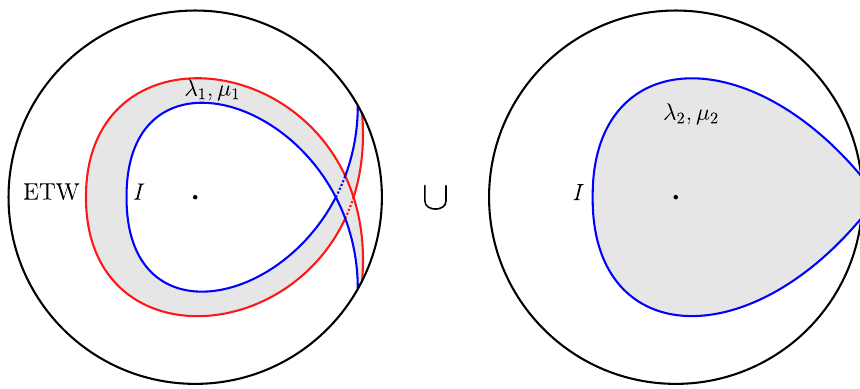
Figure 3 . The combined model containing both an ETW brane and an interface brane I . The two solutions are glued along the interface brane. Since the Euclidean horizon is not included in the left- hand solution, both branes are multiply wound relative to a single copy of Euclidean/Schwarzschild AdS avoiding